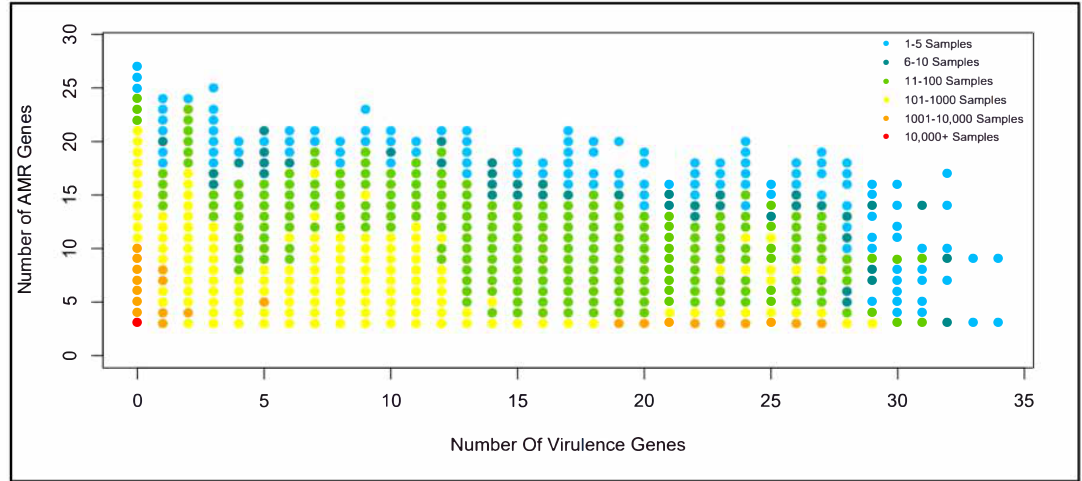
Figure 7. A comparison of the number of virulence genes and AMR genes found in individual samples from 2010–2020 in the US. Warmer colors represent higher frequencies of virulence / AMR occurrences, cooler colors represent lower